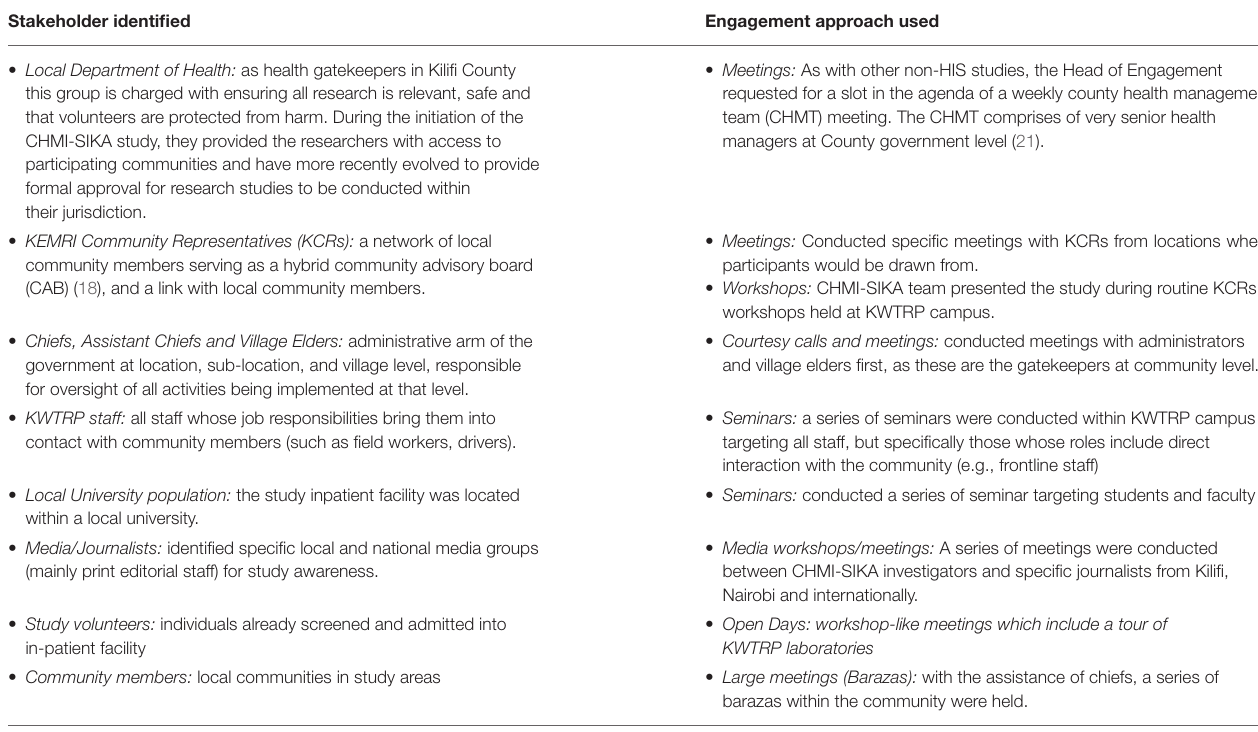
TABLE 1 | Key stakeholders identified by the CAST team for CHMI–SIKA in Kilifi and engagement approaches used. Stakeholder identified Engagement approach used